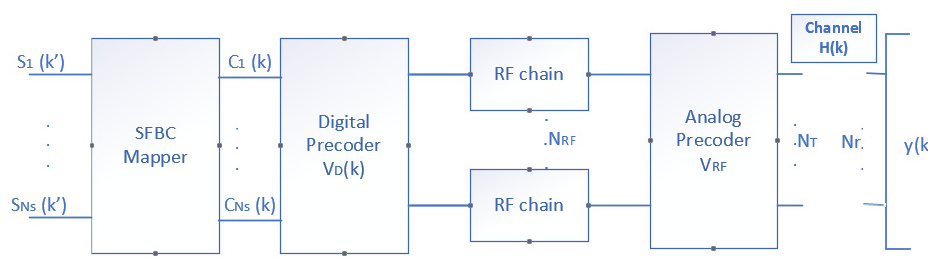
Figure 4. Block diagram of the SFBC-HBF technique.